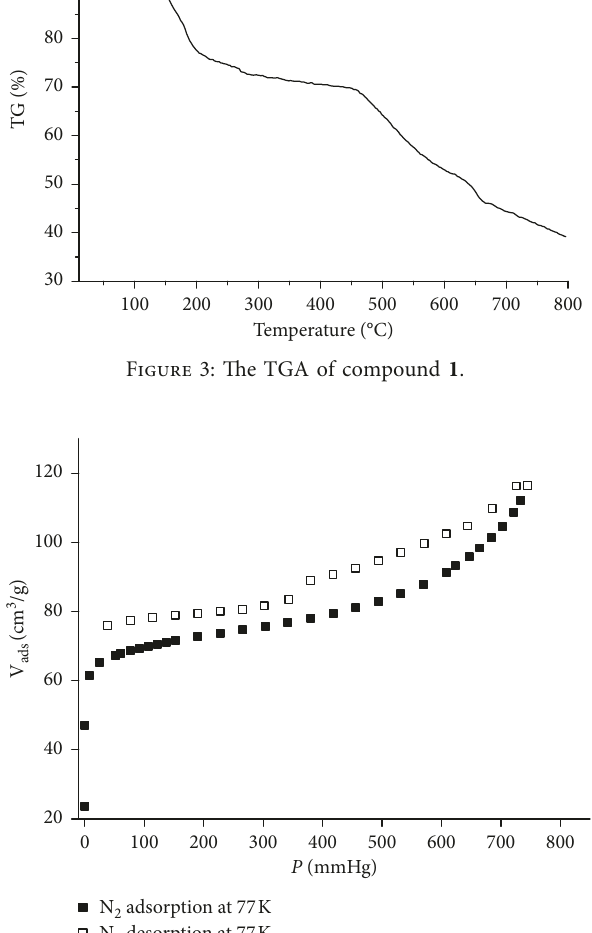
Figure 4: N 2 adsorption isotherms for compound 1 at